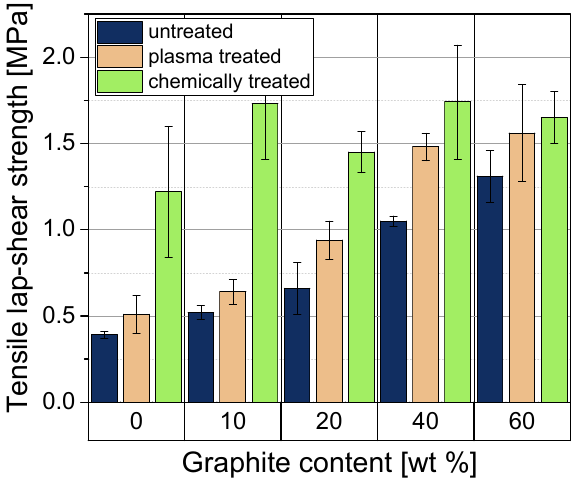
Figure 7. Tensile lap-shear strength of adhesively joined graphite composites.